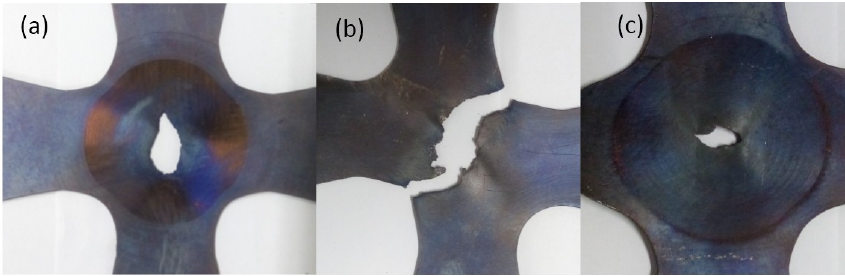
Figure 12. Fractured specimen after biaxial test ( a ) 0.1 s −1 ( b ) 0.02 s −1 ( c ) 0.005 s −1 .